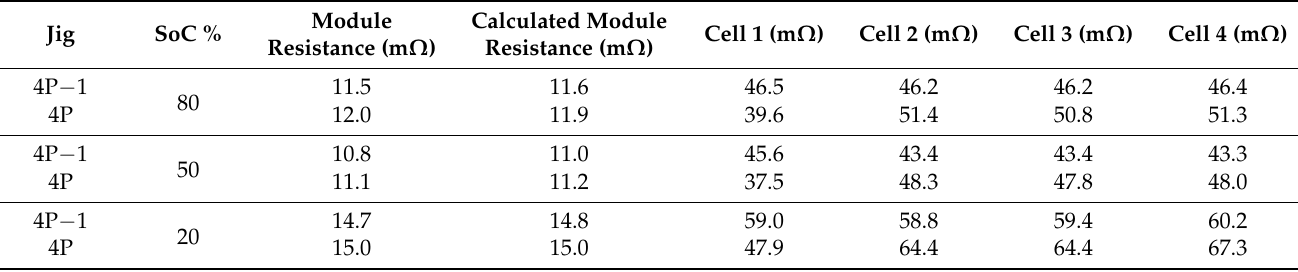
Table 1. Module and cell resistance values, determined at 80%, 50% and 20% state-of-charge (SoC) in four paral- lel configurations.